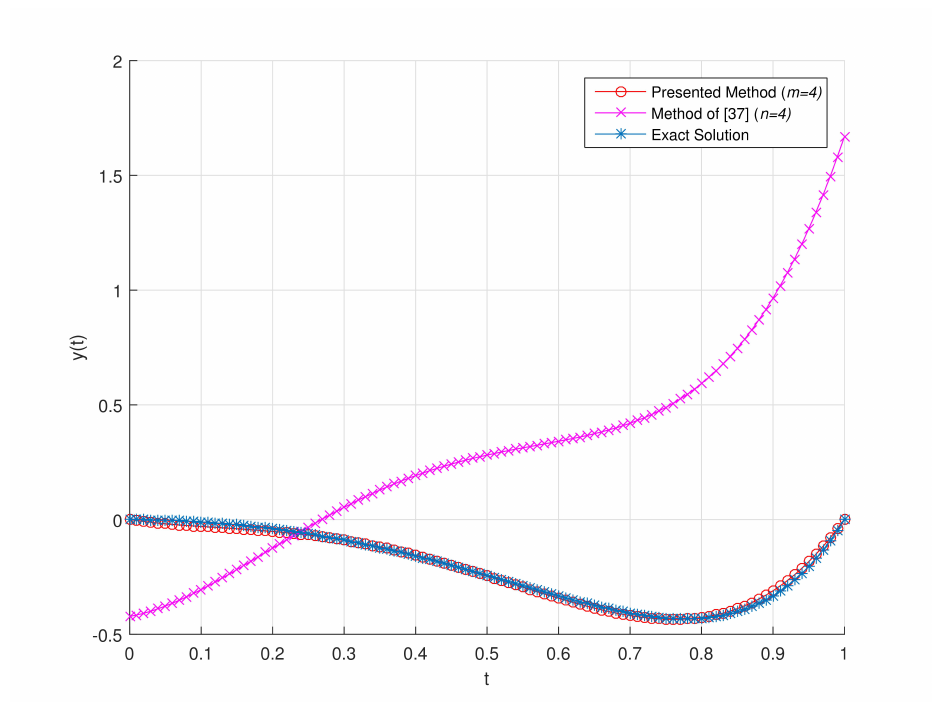
Figure 1. The comparison between exact solution and the numerical solutions obtained by proposed method and the method of [59] with m , n = 4.